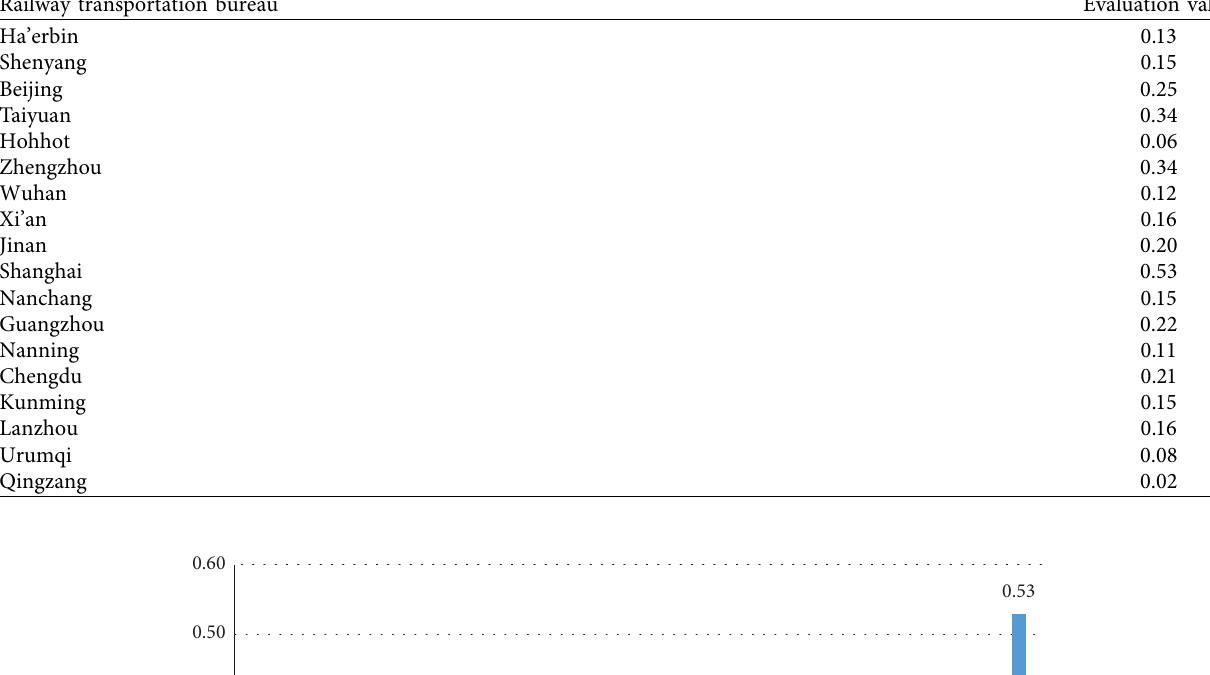
Table 4: Evaluation results of railway transportation performance.